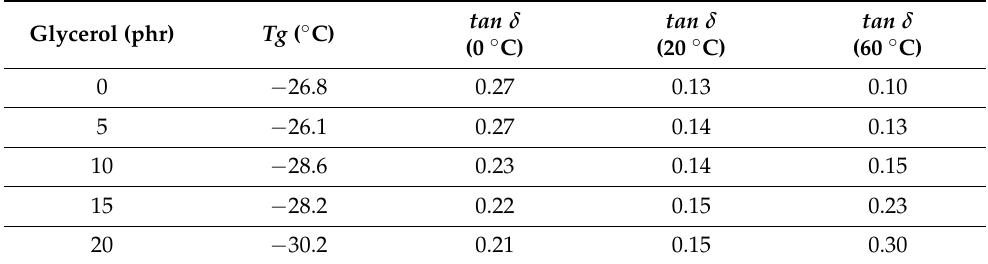
Table 3. Glass transition temperature and tan δ for vulcanizates based on SBR.